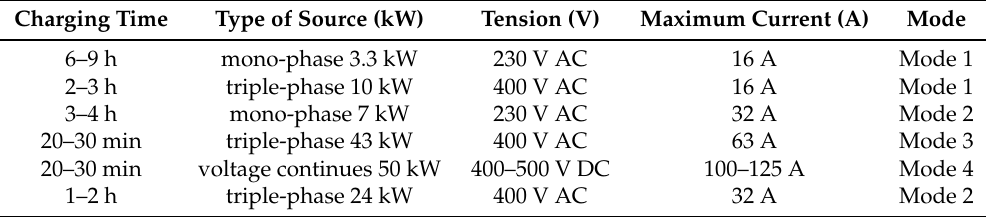
Table 2. Charging time of an EV according to charger